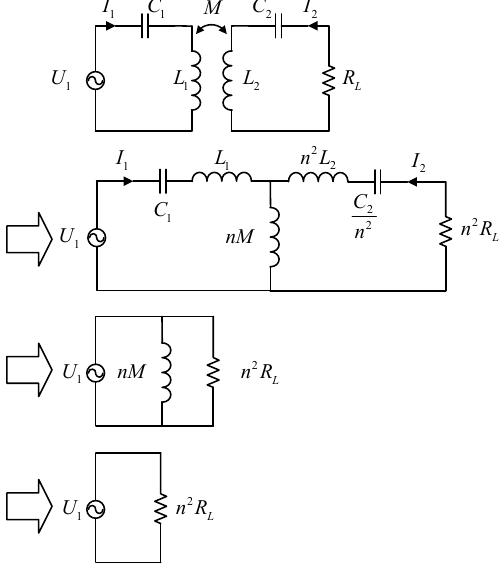
Figure 3. The SS compensation Witricity circuit using the equivalent circuit A.